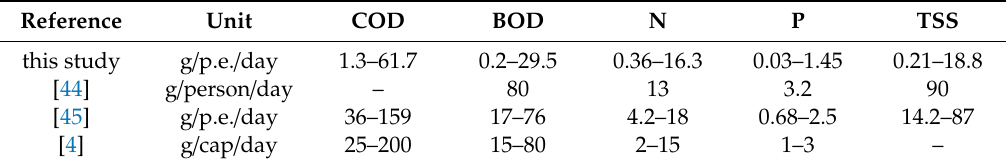
Table 2. Person load in this and various